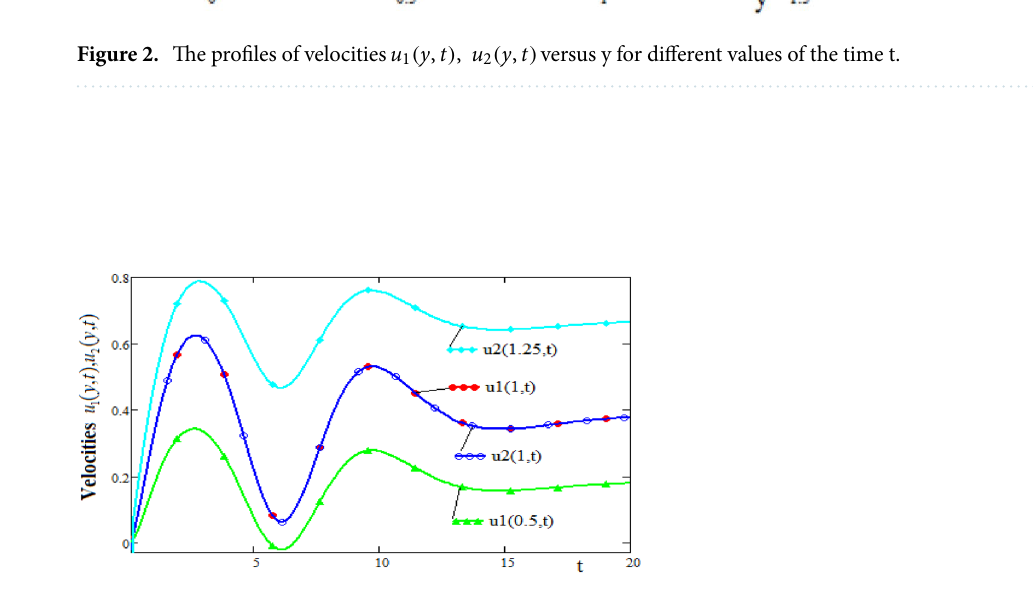
Figure 3. Time-evolution of velocities u 1 ( y , t ) , u 2 ( y , t ) in three different positions of